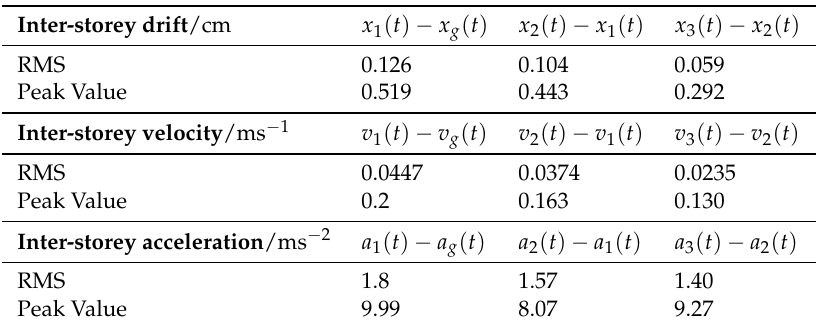
earthquake signal. Table 1. Root mean square values (RMS) and peak values for inter-storey drift, velocity and acceleration without magneto–rheological (MR)